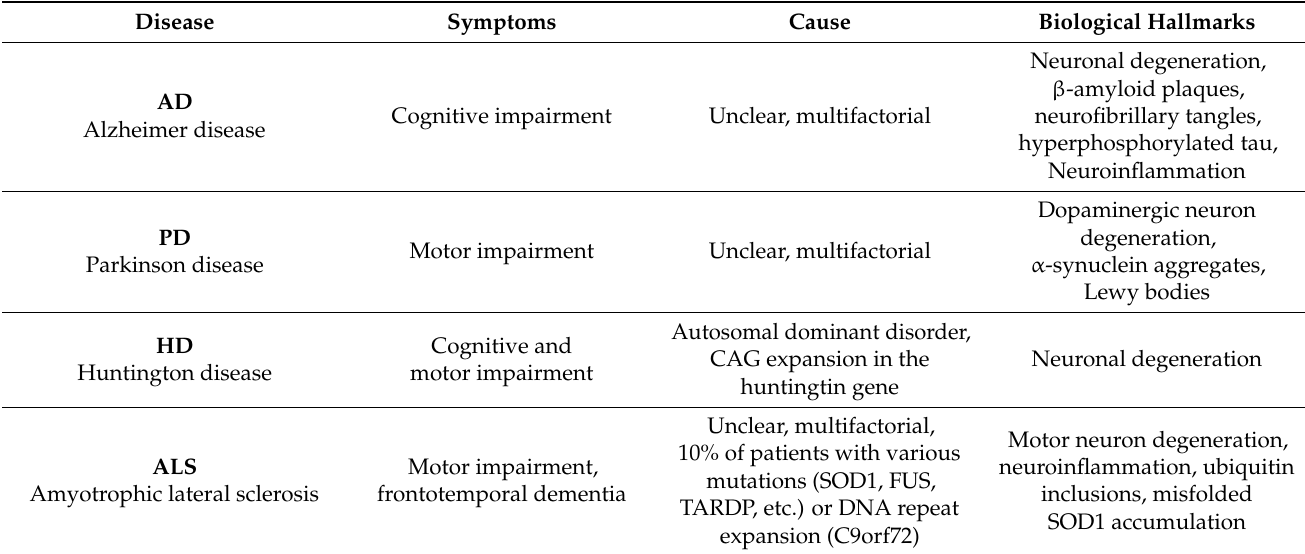
Table 1. Summary of the 4 main neurodegenerative diseases with their main symptoms, causes, and biological